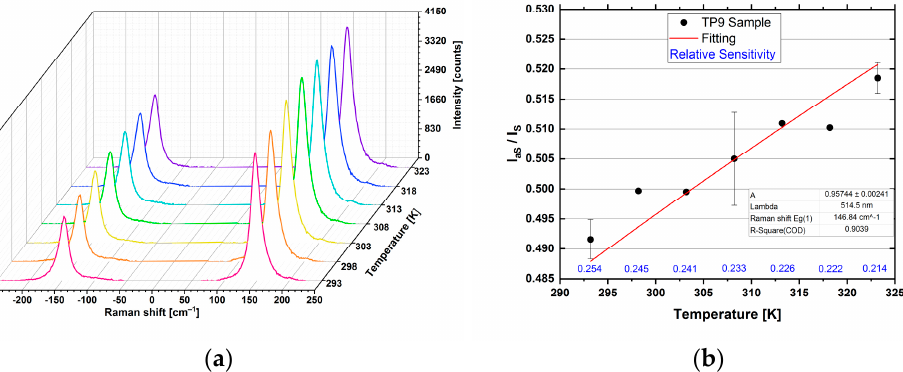
Figure 11. Thermometry carried out on sample TP9. Raman Stokes and anti-Stokes spectra acquired at 514.5 nm, at 1 mW and 1 s × 5 a ( a ). Calibration curve, through the connection of the data with the thermometric equation ( b ).